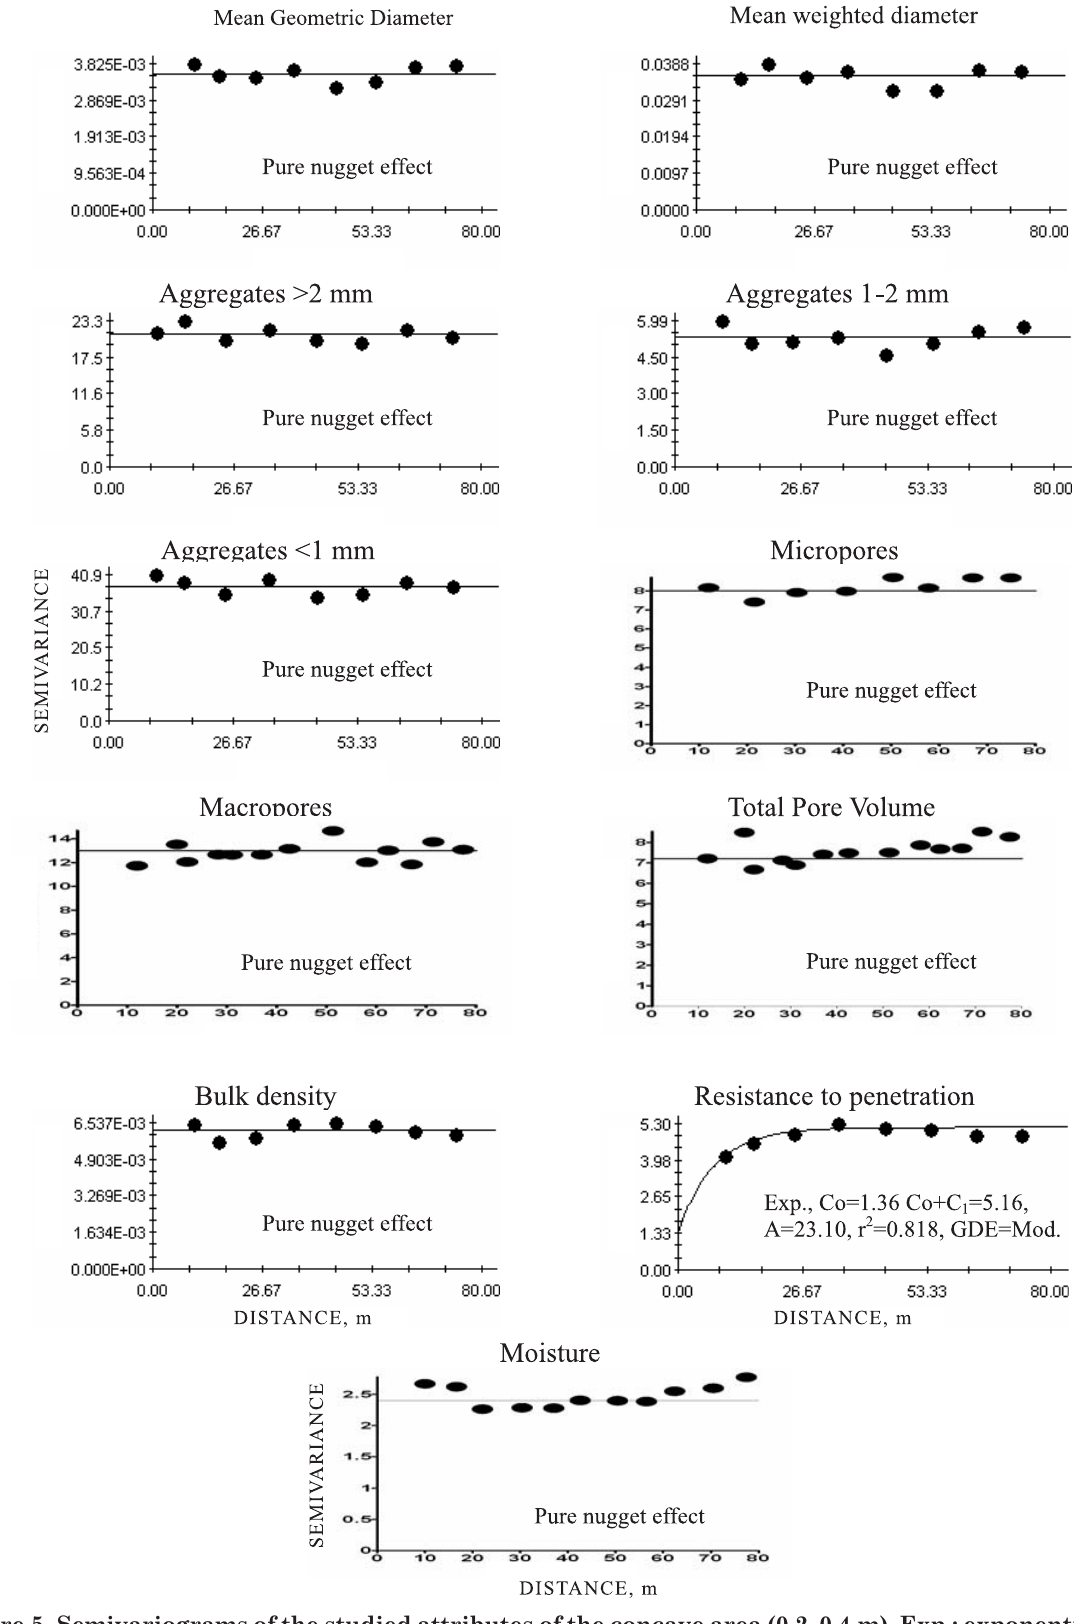
Figure 5. Semivariograms of the studied attributes of the concave area (0.2–0.4 m). Exp.: exponential; Co: nugget effect; C : sill; a: range (m); r 2 = coefficient of 1